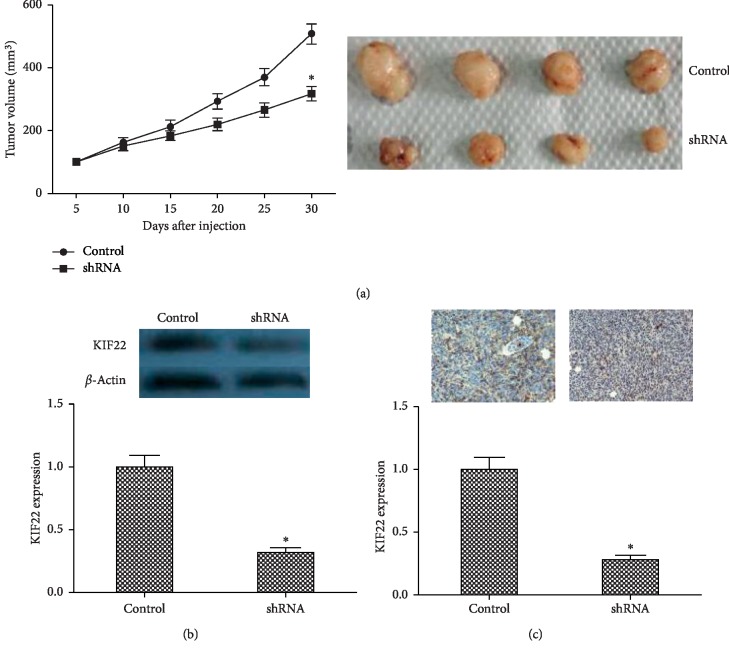
Knockdown KIF22 inhibited xenograft tumor growth. (a) Tumor growth curve in nude mice (left). CAL-27 cells and shCAT-27 were injected subcutaneously into the armpit of mice, tumor size was measured every 3 days, and tumor volume was calculated. Representative images of xenograft tumor (right). (b) Protein expression level of KIF22 in xenograft tumor by western blot. (c) Representative images of immunohistochemical staining of KIF22 in xenograft tumors (top) and qualification (bottom).